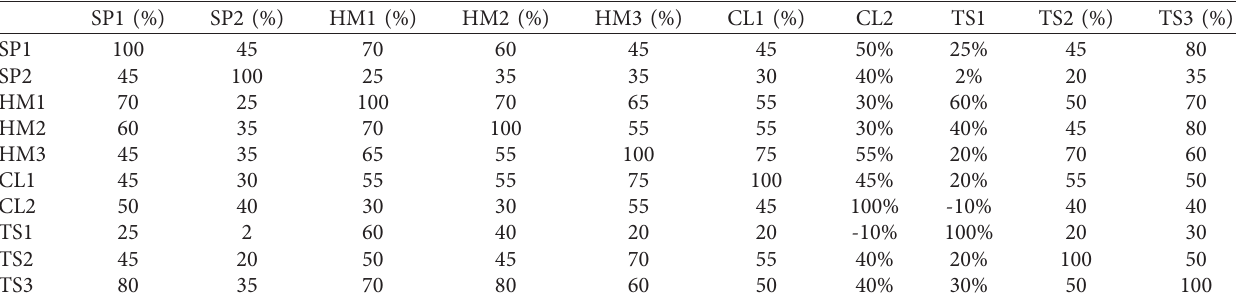
Table 2: Learning behavior characteristic